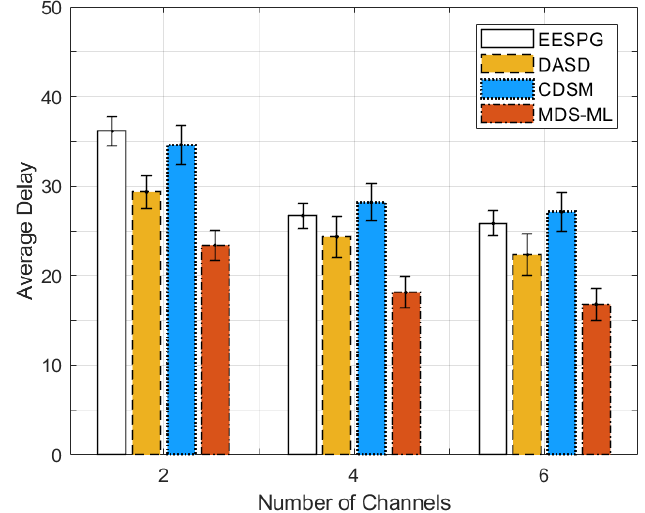
Figure 7. Average delay with different number of